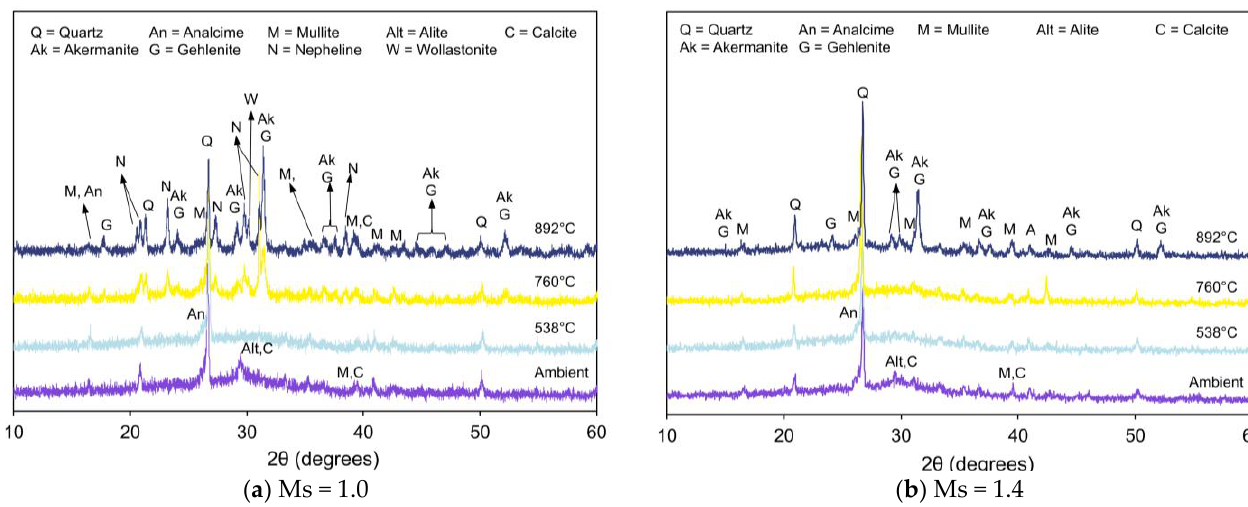
Figure 7. XRD pattern of FS 40P on exposure to elevated temperature.